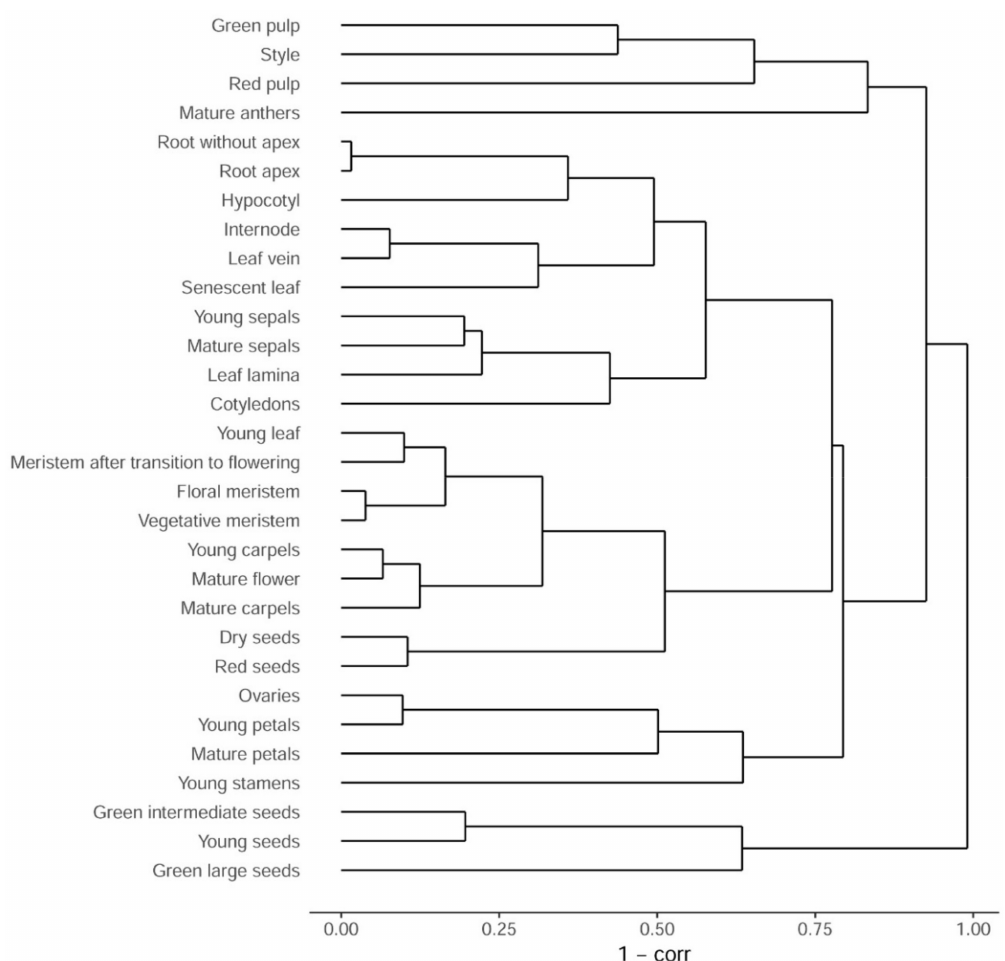
Figure 1. Hierarchical clustering of samples as represented by a clustering tree. Distance between samples is measured as 1 − Pearson r 2 correlation coe ffi